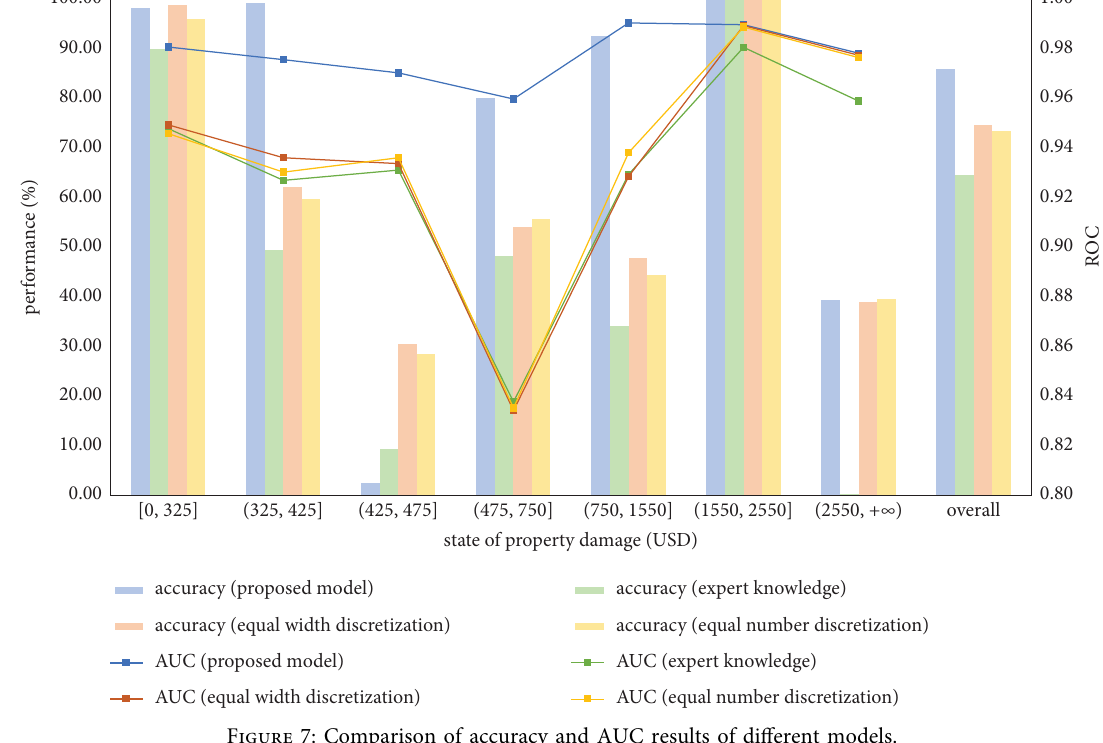
Figure 7: Comparison of accuracy and AUC results of diferent models.